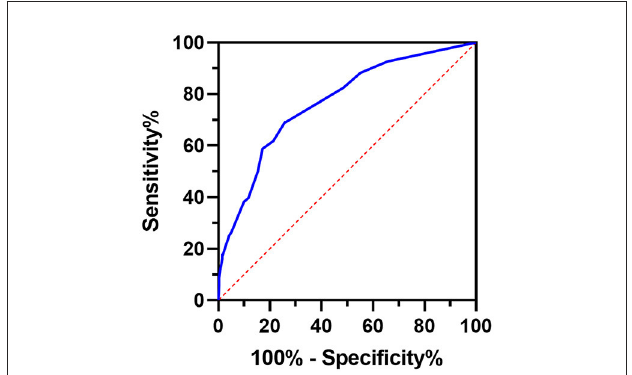
FIGURE3 ROC curve of the Barthel Index in patients with COVID-19. ROC curve indicates the sensitivity and specificity of the Barthel Index in predicting the prognosis of patients with COVID-19. The AUC was 0.764 (95%CI: 0.701–0.827).